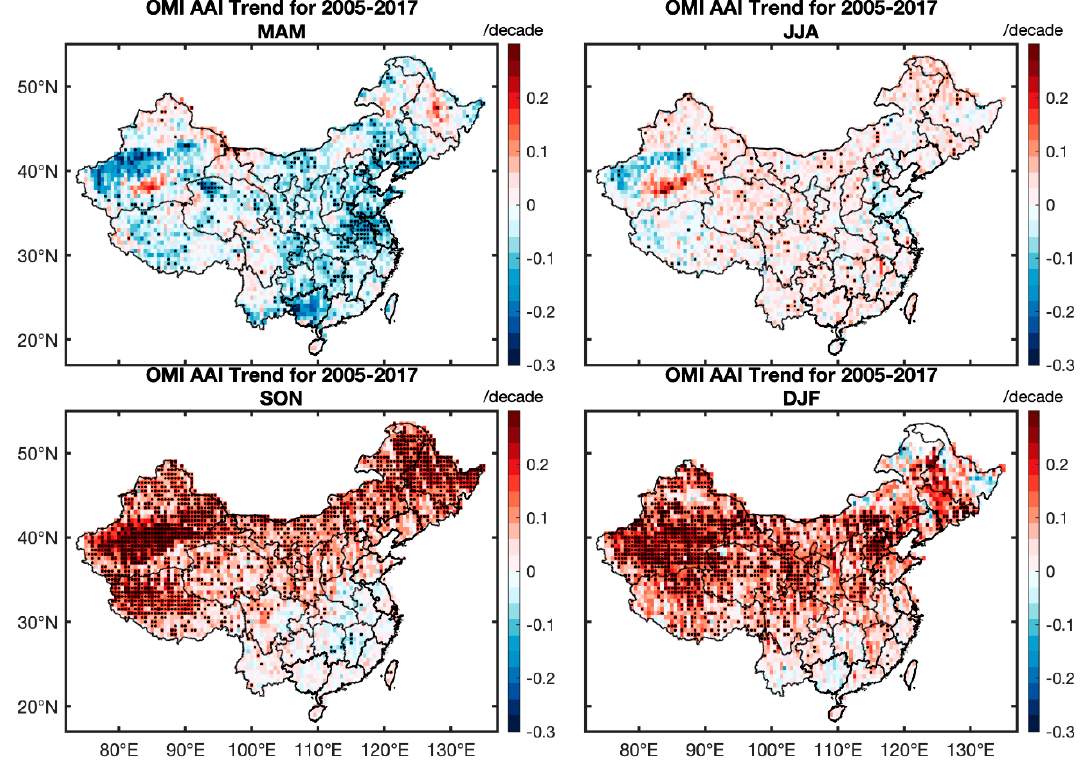
Figure 7. Seasonal OMI AAI trend for 2005–2017.